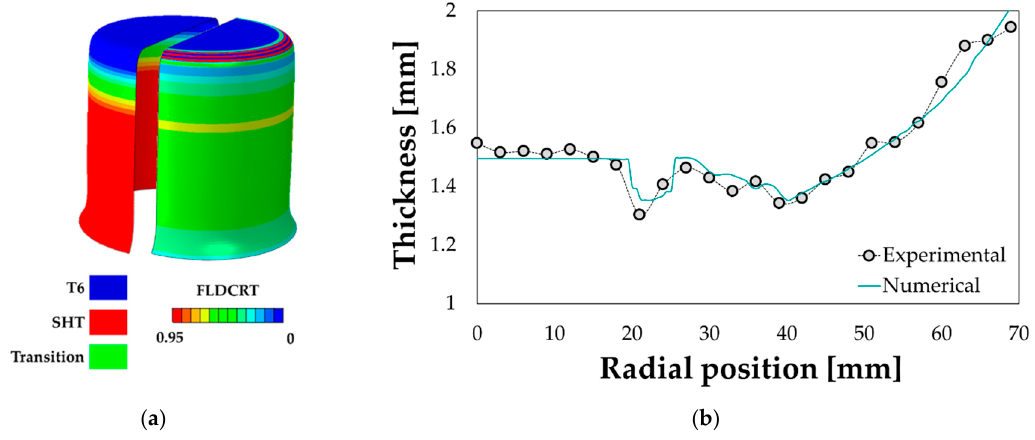
Figure 26. Validation of the optimization prediction: ( a ) numerical distribution of material properties and strain severity (FLDCRT), ( b ) numerical vs. experimental thickness distribution.